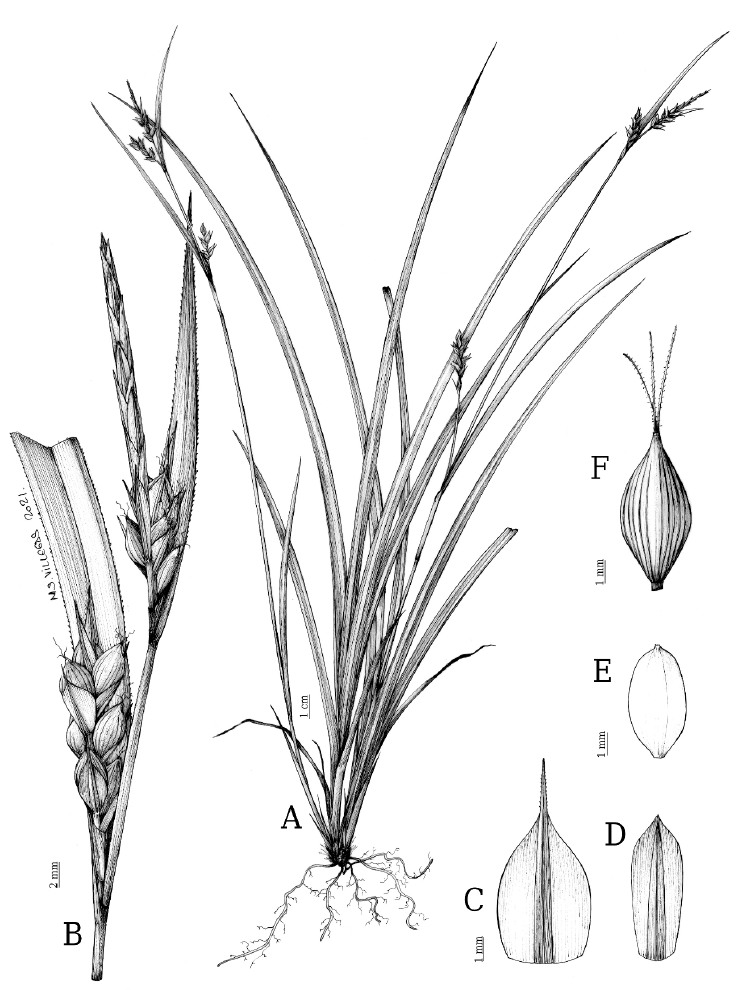
Figure 3. Carex olbiensis . A, General aspect; B, Inflorescence; C, Female glume; D, Male glume; E, Achene; F,